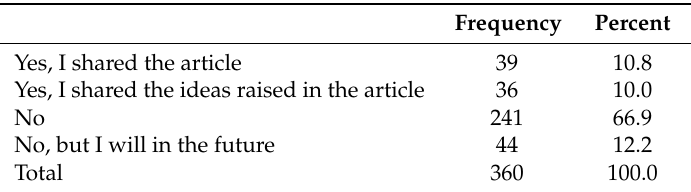
Table 26. Was the article reading